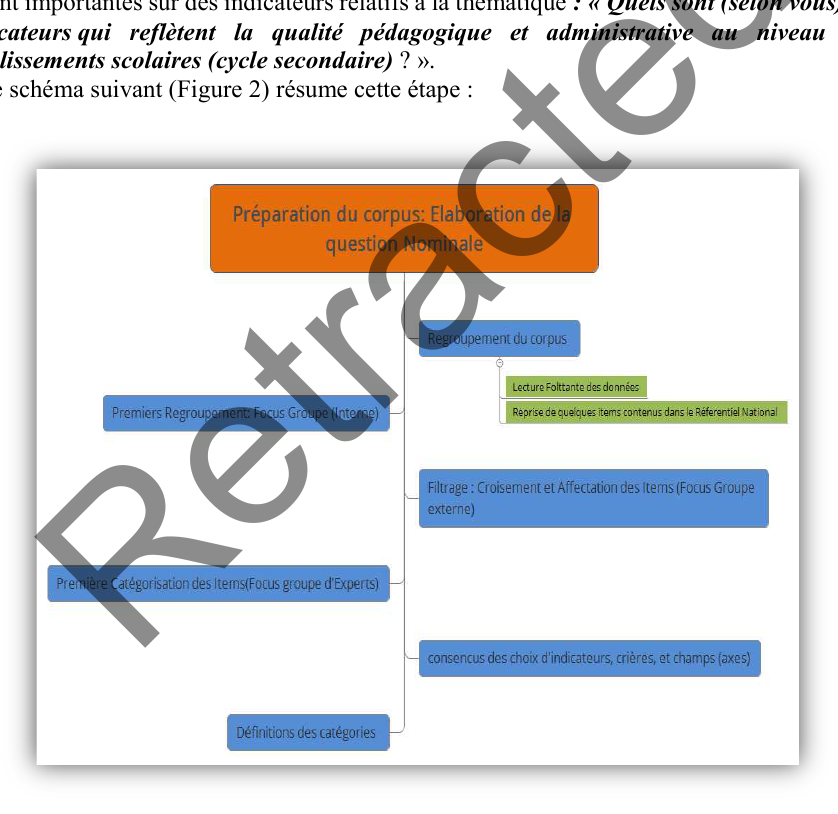
Figure 2 : Recueil des données